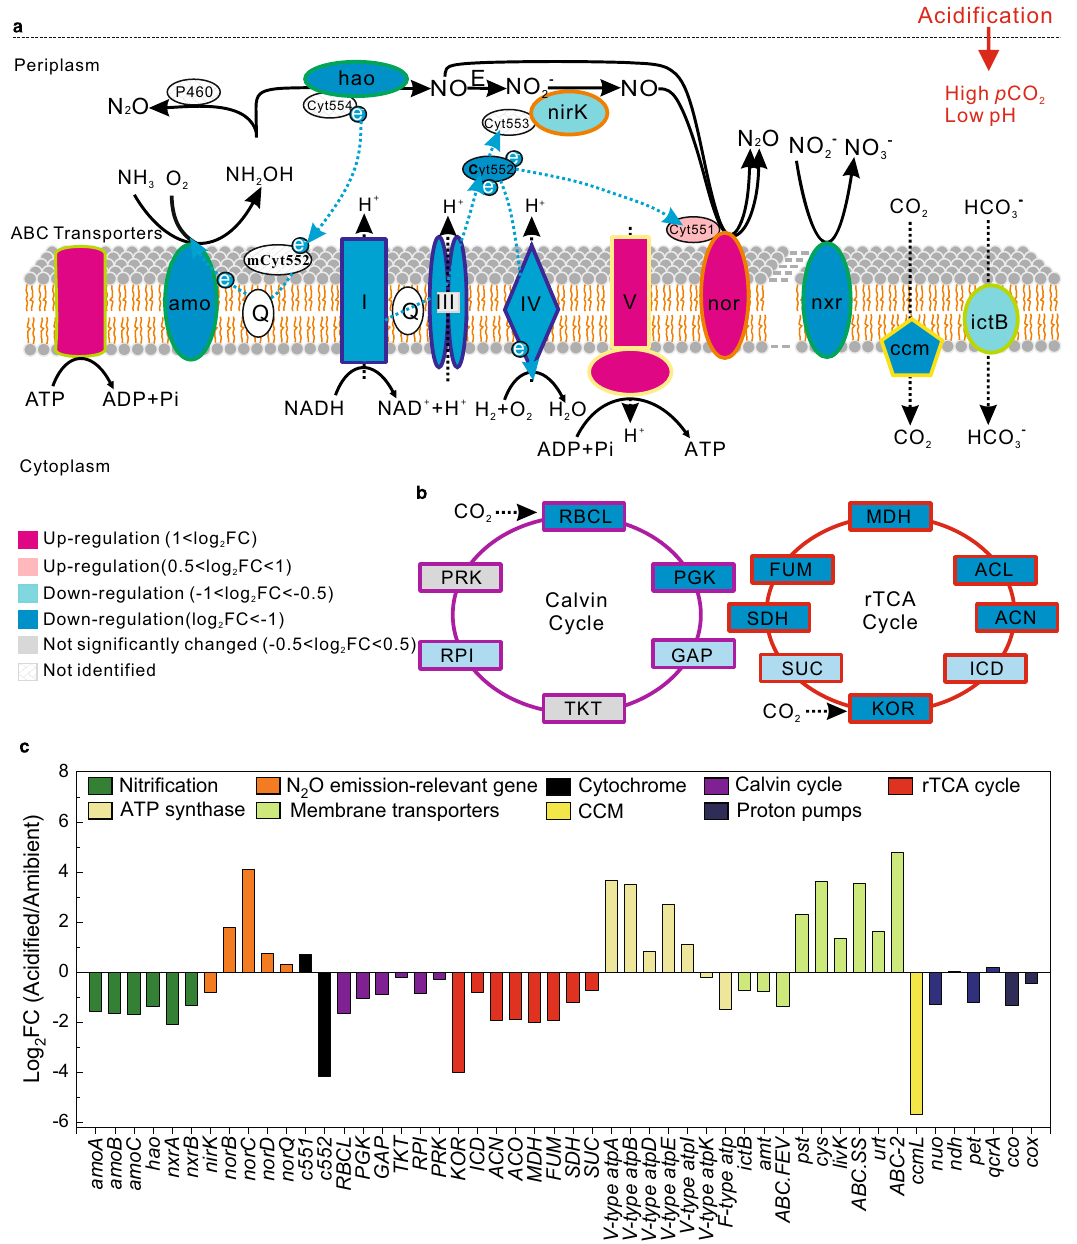
Fig. 4 | Response of bacterial nitri fi ers to acidi fi cation. a Schematic model depicting the effects of acidi fi cation on the expression of genes involved in the stepwise oxidation of NH 3 (NH 3 → NH 2 OH → NO → NO 2 − → NO 3 − ), N 2 O production, energy generation, and cytosolic pH homeostasis of nitrifying bacteria. The membraneisbrokenbydottedline,asnitriteoxidationdoesnotoftenoccurinthe sameorganismwithammoniaoxidation,withtheexceptionofrecentlydiscovered comammox Nitrospira .Foldchange(FC)inrelativegeneexpressionwascalculated by comparing the acidi fi ed samples to the ambient control. The roman numbers refer to the enzyme complex I (NADH dehydrogenase), complex III (cytochrome